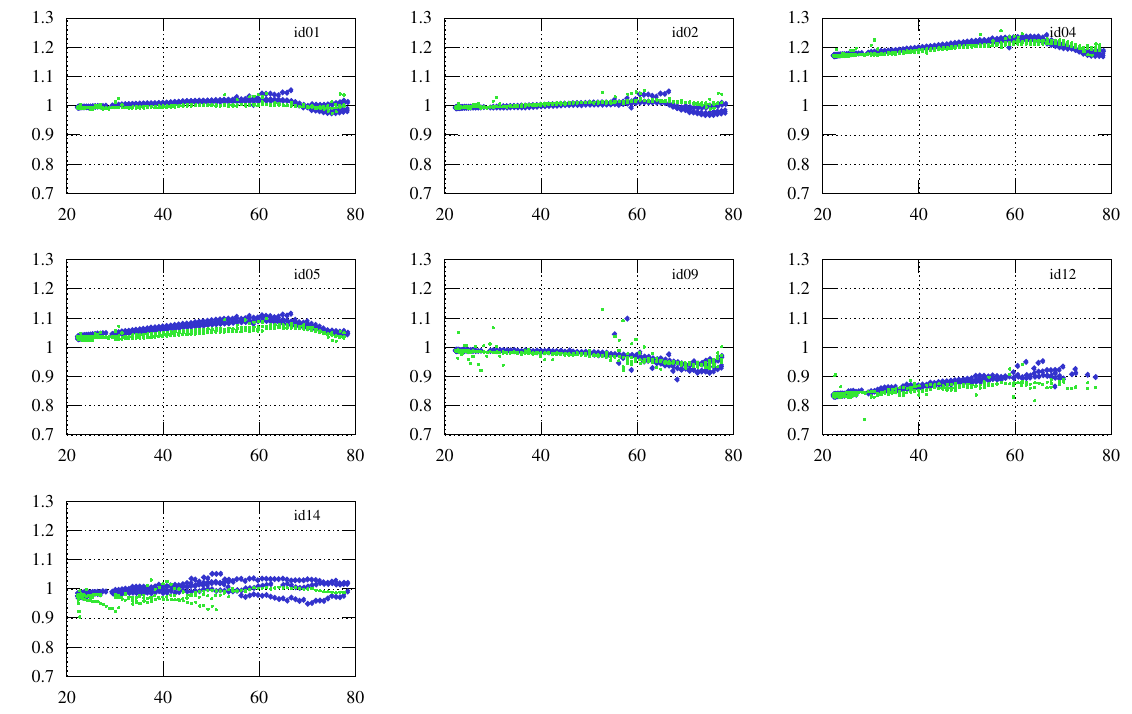
Fig. 8. Ratios between clear-sky UV-A irradiance measurements with user instruments and the reference (vertical axis) against the solar zenith angle (horizontal axis). Morning (blue) and afternoon (green) measurements are plotted